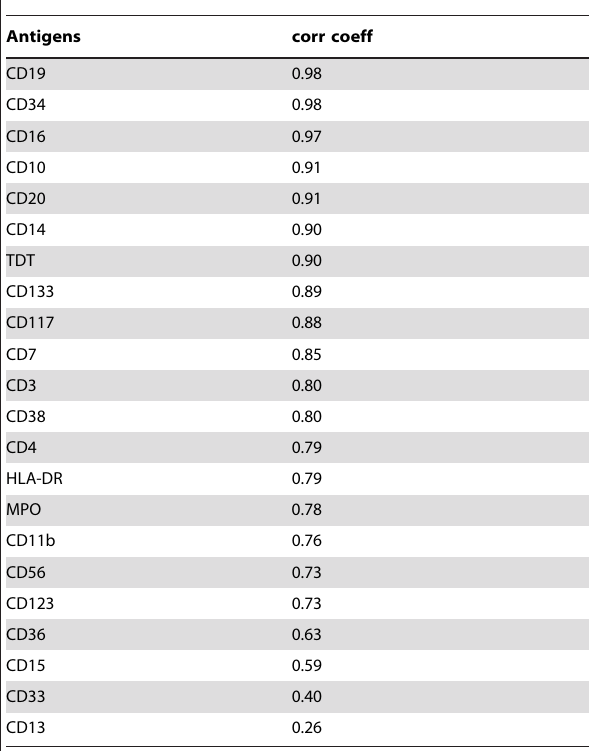
Table 2. Analysis of leukemic blasts: correlation between results from flow cytometry and nCounter analysis for twenty- two different antigens, each studied in forty-five leukemia